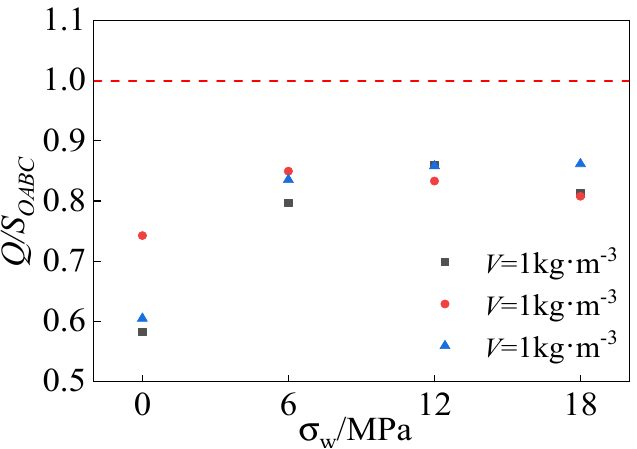
Figure 29. Relationship between energy consumption coefficient and confining pressure value and fiber content.